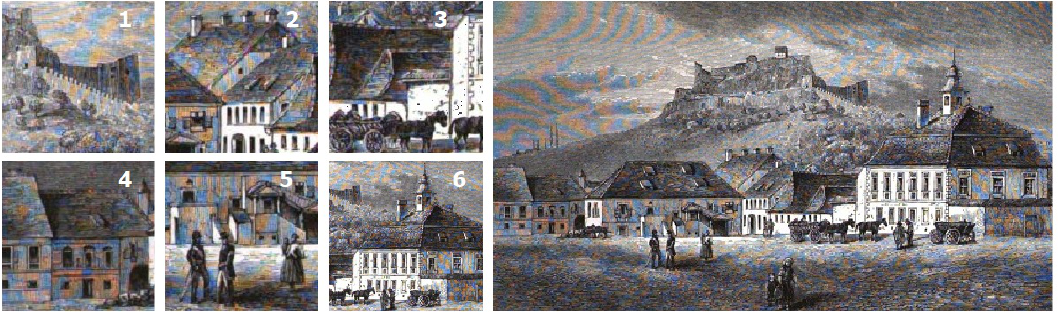
Figure 3: Lithograph on Reps – wood engraving by G. Pearson (published in Boner, 1865, p. 244) 1 – The original merlons of the stronghold, 2 – The building that is currently occupied by the local police station, 3 – Wooden cart wheels, 4 – Buildings preserved to date, 5 – Imperial and Royal